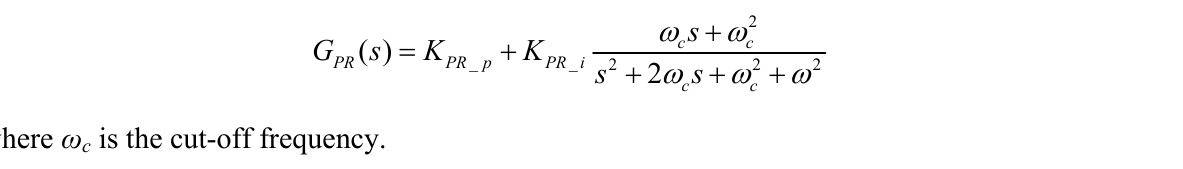
Figure 8. Bode-plot of ideal PR controller; K